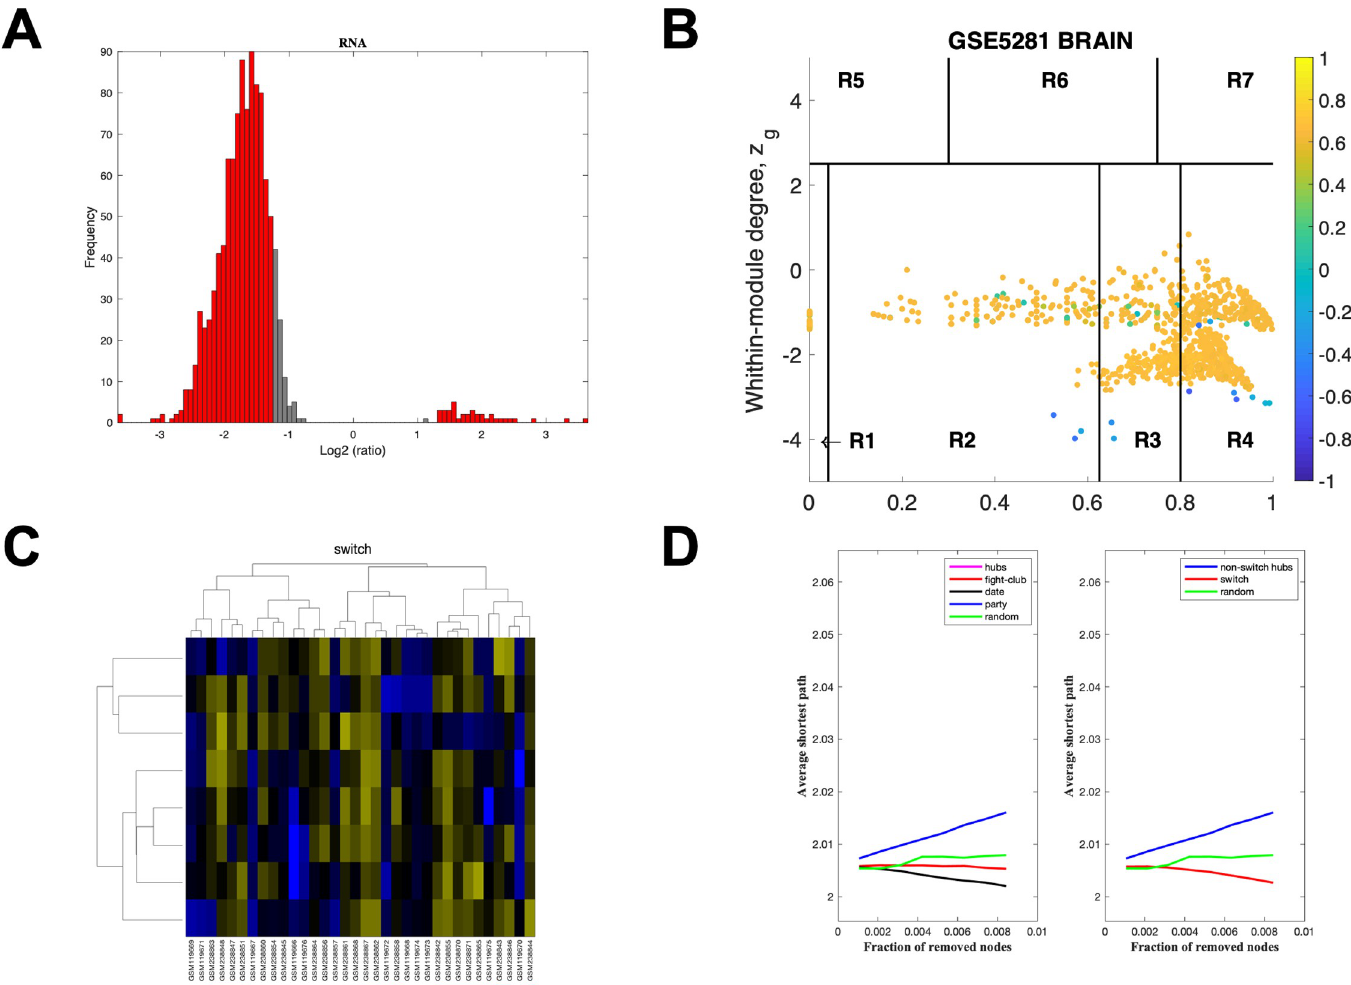
Fig 7. SWIM analysis of the superior frontal gyrus. A. Distribution of the fold-change values for GSE5281 brain microarray gene expression data from the SFG. The x- axis represents the fold-change value (log2 of the fold-change) that is the ratio of the average expression data in AD patients compared to the average expression data in normal controls computed for protein-coding and non-coding RNAs. The y-axis represents the frequency of the obtained fold-change values. The grey bars represent the fold-change values associated with protein-coding and non-coding RNAs that will be discarded according to the selected threshold. The red bars represent the fold-change values associated with protein-coding and non-coding RNAs that were retained for further analysis. B. Heat cartography map for GSE5281 brain data from the SFG. correlation network. The plane is identified by two parameters: Zg (within-module degree) and Kπ (clusterphobic coefficient) and it is divided into seven regions each defining a specific node role (R1-R7). High Zg values correspond to nodes that are hubs within their module (local hubs), whereas low Zg values correspond to nodes with few connections within their module (non-hubs within their communities, but they could be hubs in the network). Each node is colored according to its average Pearson Correlation coefficient (APCC) value. Yellow nodes are party and date hubs, which are positively correlated in expression with their interaction partners. Blue nodes are the fight-club hubs, which have an average negative correlation in expression with their interaction partners. Blue nodes falling in the region R4 are the switch genes, which are characterized by low Zg and by high Kπ values and are connected mainly outside their module. C. Dendrogram and heat map for switch genes in GSE5281 brain microarray gene expression data from the SFG. The expression profiles of switch genes (including protein-coding and non-coding RNAs) are clustered according to rows (switch genes) and columns (samples) of the switch genes expression data (biclustering). The colors represent different expression levels that increase from blue to yellow. The red line under the x axis labels denotes AD samples. D. Robustness for the GSE5281 brain correlation network from the SFG. The x-axis represents the cumulative fraction of removed nodes, while the y-axis represents the average shortest path. The shortest path between two nodes is the minimum number of consecutive edges connecting them. Each curve corresponds to the variation of the average shortest path of the correlation network as function of the removal of nodes specified by the colors of each